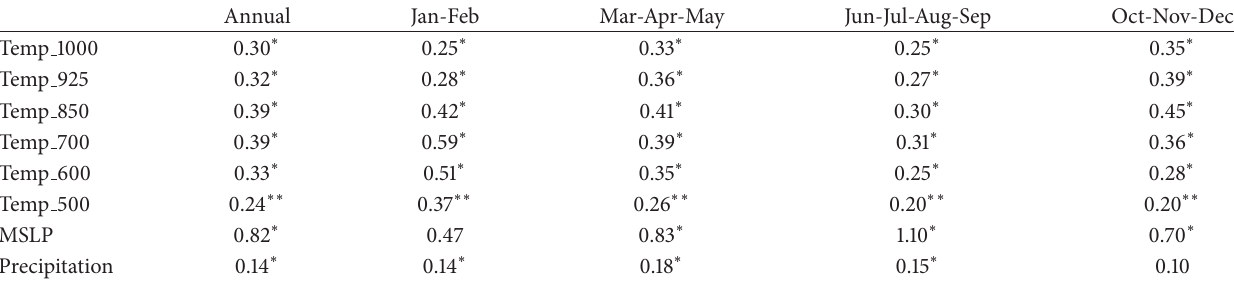
Table 11: Recent 10-year changes in temperature, MSLP, and